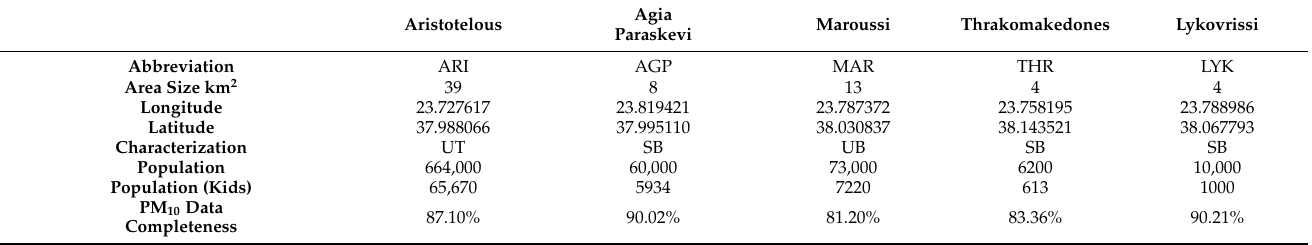
Table 1. The characteristics of the examined air pollution monitoring stations within the GAA. Aristotelous Agia Paraskevi